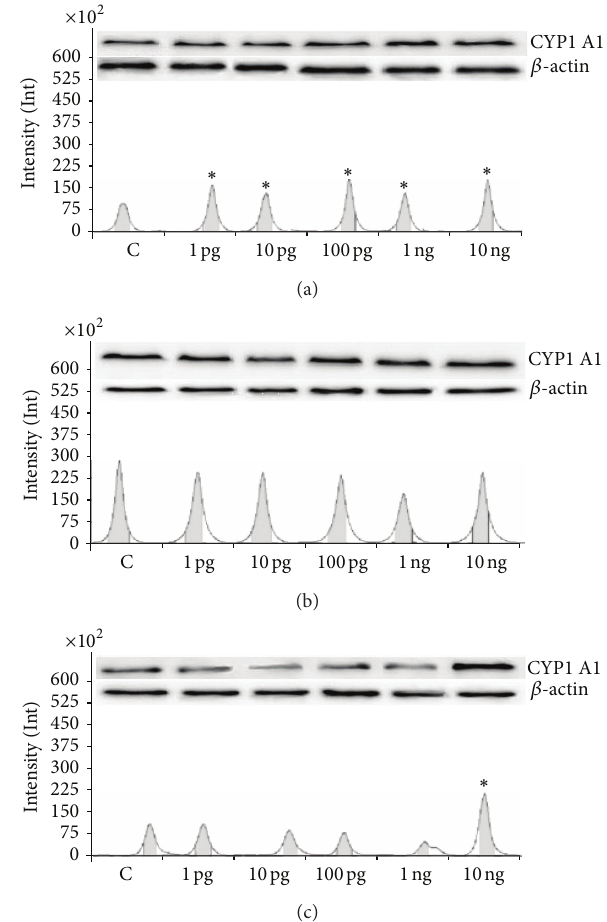
Figure 2: (a) Protein expression (immunoblot) of CYP1 A1 after 1 (a), 6 (b), and 48 (c) hours of incubation with Halowax 1051. The amount of protein in each sample was checked using an anti- 𝛽 - actin antibody. All means marked with ( ∗ 𝑃 < 0.05 ) are significantly different from the